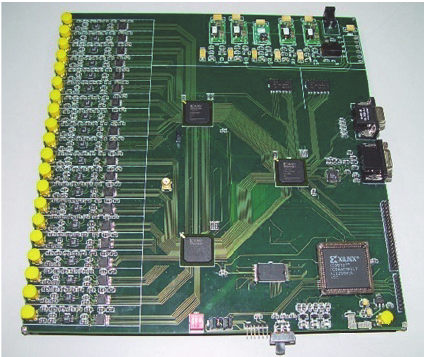
Figure 10: The snapshot of our developed PCB.